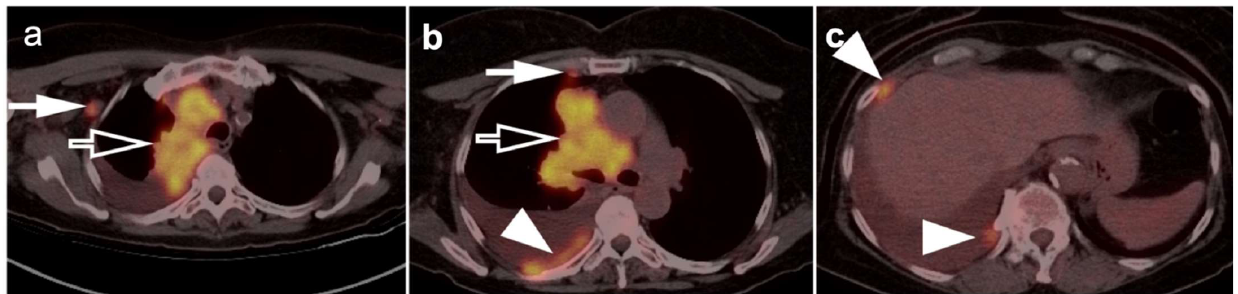
Figure 12. “Extensive disease” small cell lung cancer. ( a – c ) Fused axial FDG PET/CT images from a patient with biopsy-proven small cell lung cancer demonstrating an infiltrative, hypermetabolic mass in the right upper lobe extending into the mediastinum ( open arrow ). In addition, there are multiple metastatic lesions ( white arrows ), including a hypermetabolic lymph node in the right axilla ( a ), a right internal mammary node ( b ) and multiple focal tumor implants along the pleural surface ( white arrowheads , b , c ) associated with a large pleural effusion with metabolic activity within the fluid. Even though the tumor is confined to ipsilateral hemithorax, due to the presence of hypermetabolic pleural deposits, and axillary and internal mammary involved nodes, this patient is staged as “extensive disease small cell lung cancer” (ED-SCLC) rather than as “limited disease small cell lung cancer” (LD-SCLC).